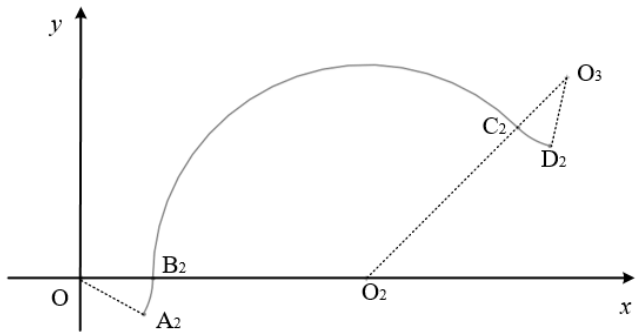
Figure 12. Track structure.